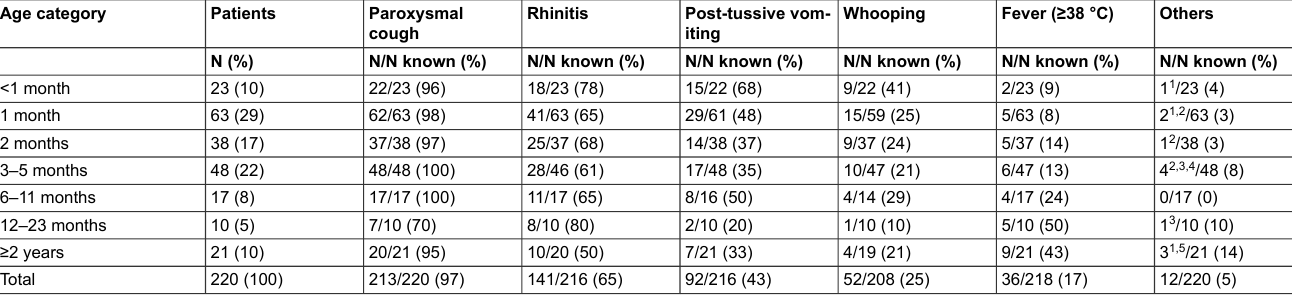
Table S4: Signs and symptoms by age categories.*